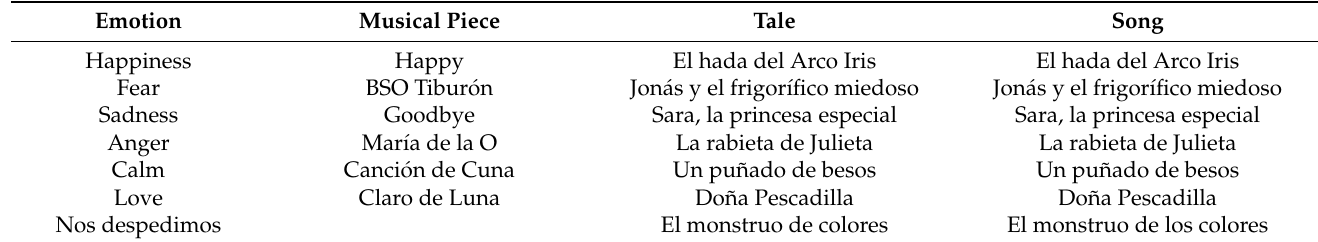
Table 1. Selection of musical works, stories, and